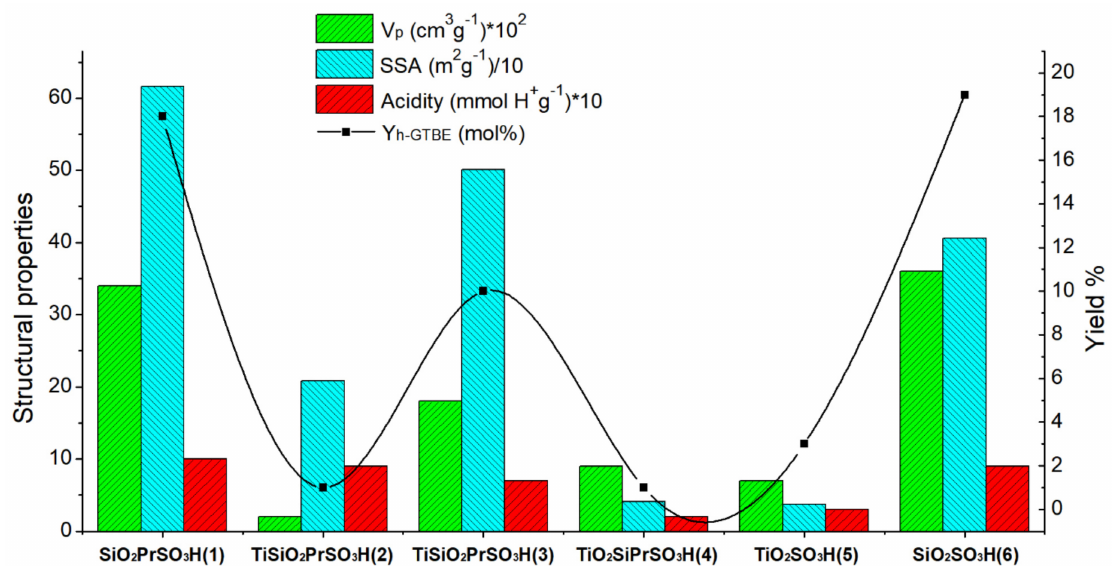
Figure 9. Performance of the catalysts: structural properties and acidity vs yield.